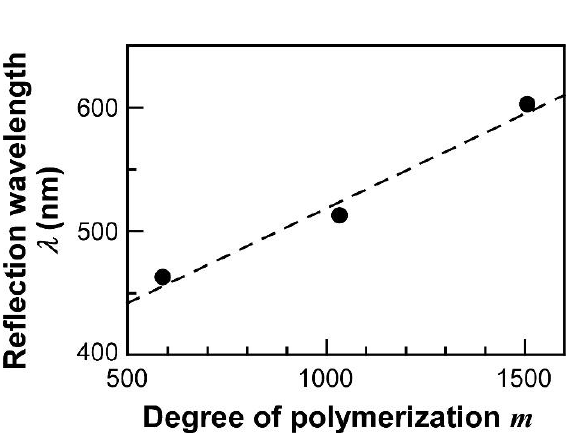
Figure 4. The relationship between the degrees of polymerization ( m ) of POA chains on the surface of SiPs and the maximum wavelengths of reflection bands ( λ ) of the CC films. The dashed line represents the linear regression line for the plots.